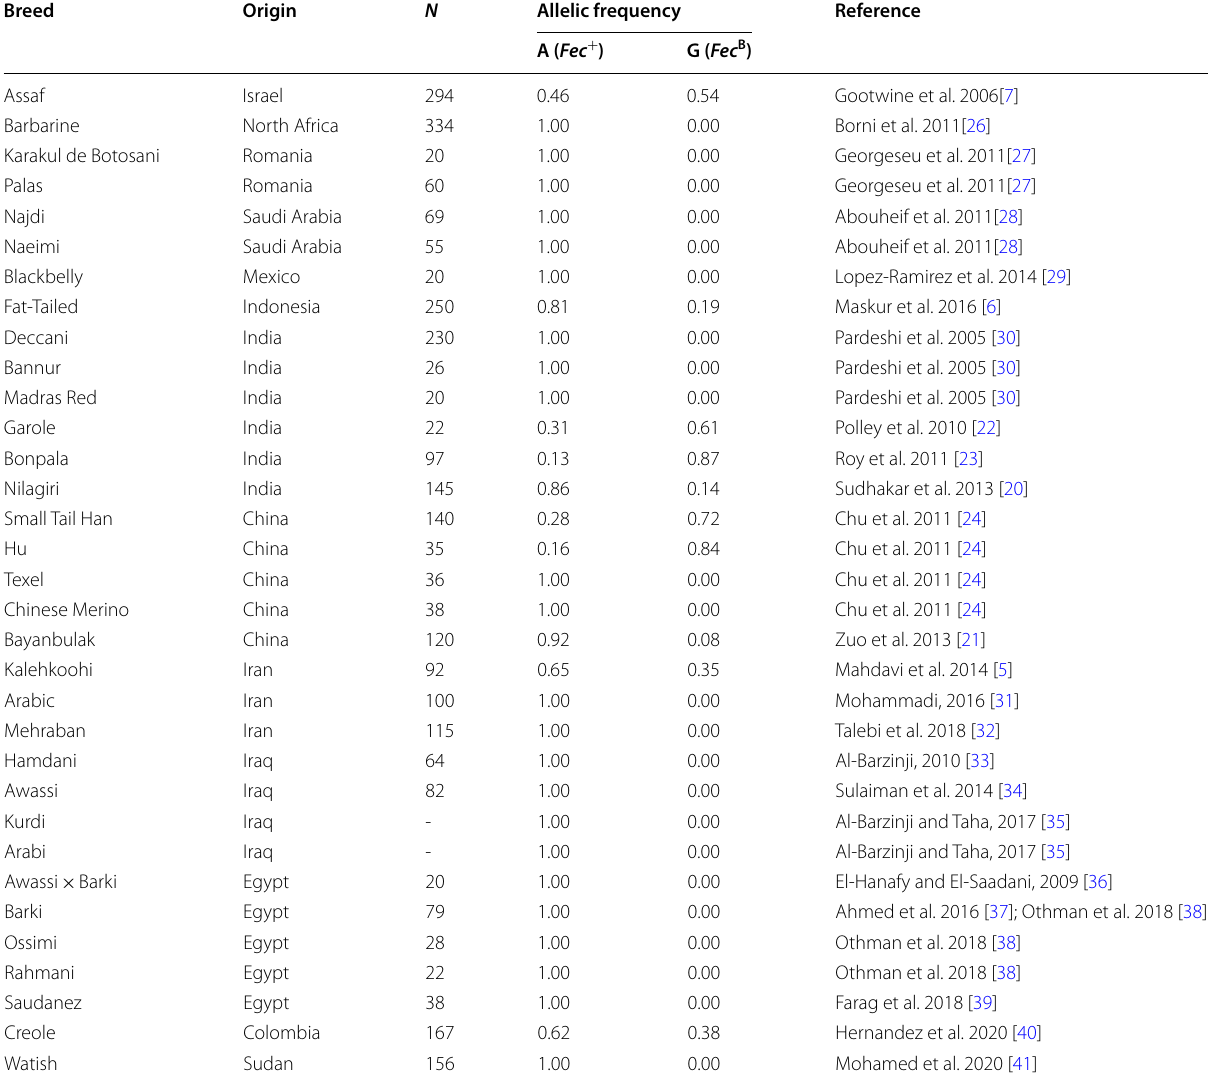
Table 3 Allelic frequency in the BMPR1B/ Ava II gene in many sheep breeds